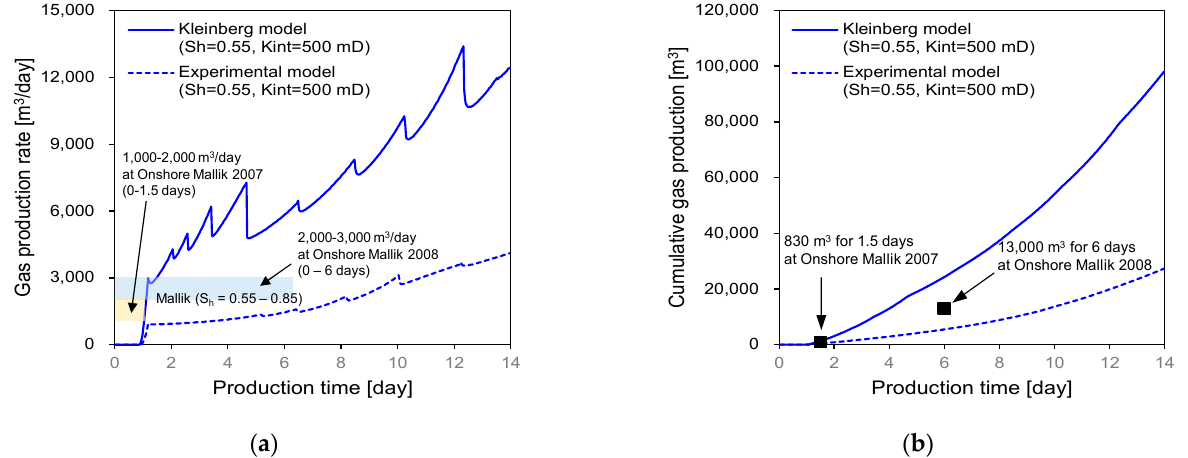
Figure 10. Indirect comparative verification analysis between the Kleinberg model and experimental model using Mallik test data: ( a ) gas production rate; ( b ) cumulative gas production.